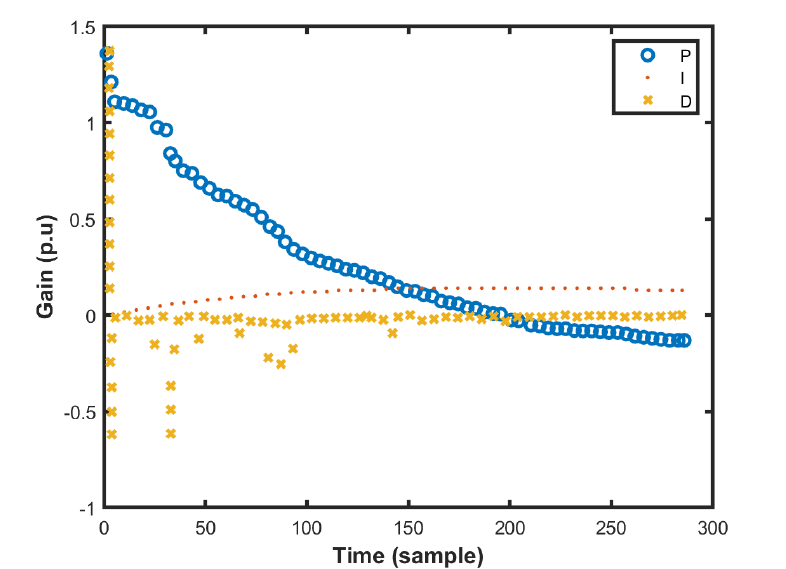
Figure 19. Individual control response during the